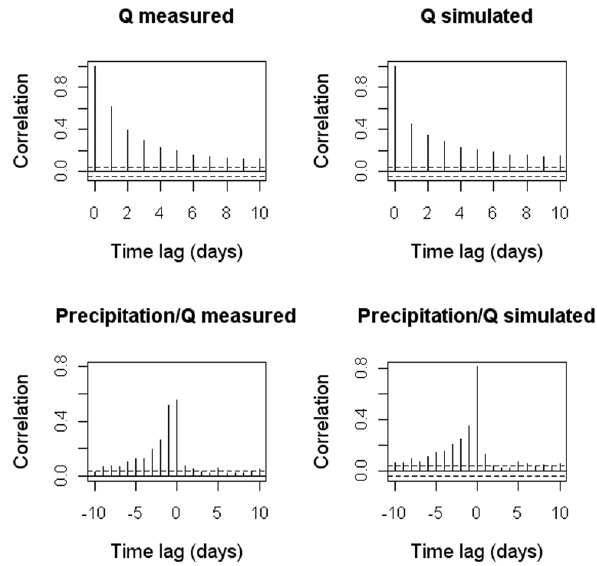
Fig. 8. Autocorrelations of measured discharge, simulated discharge and residuals and cross correlations of precipitation with measured discharge, simulated discharge and